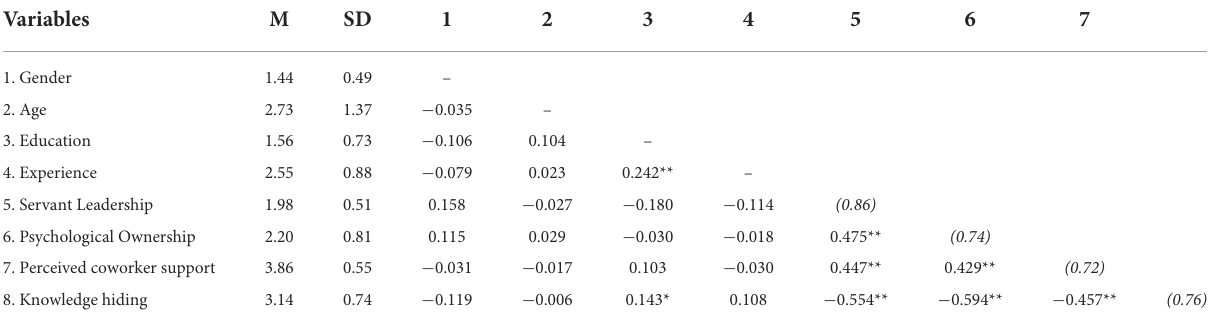
TABLE 2 Descriptive statistics, Cronbach alpha, and